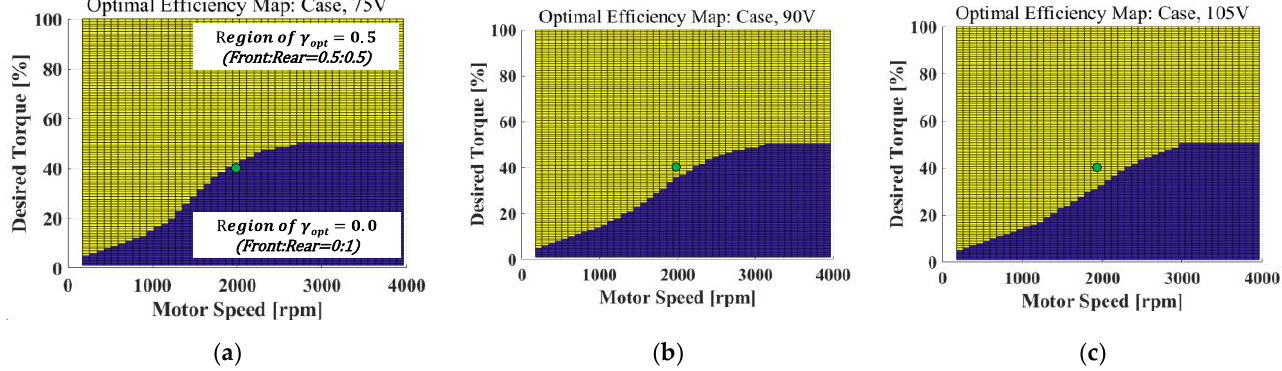
Figure 11. Optimal front/rear distribution ratios with regard to the speed and desired torque: ( a ) at V dclink = 75 V, ( b ) at V dclink = 90 V ( V norm ), and ( c ) at V dclink = 105 V.